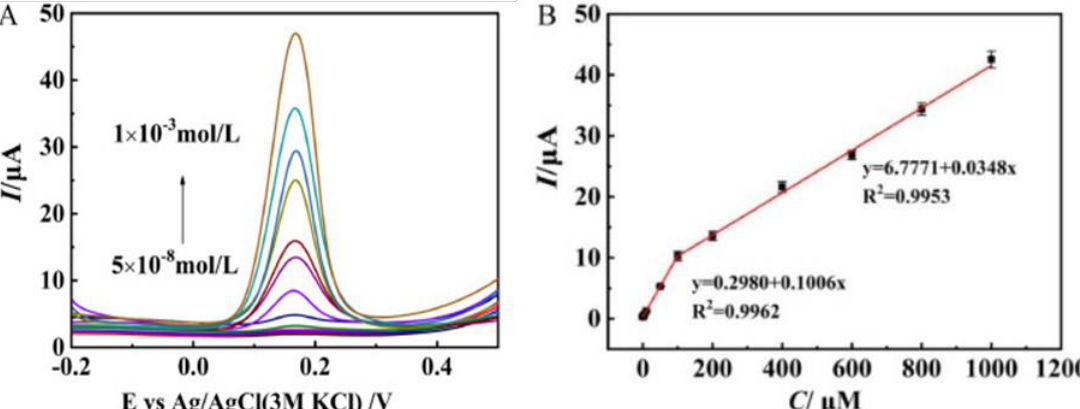
Figure 8. ( A ) DPV curves of S-MoSe 2 / NSG / Au / MIP / GCE to dopamine (DA) concentrations from 5 × 10 − 8 to 1 × 10 − 3 mol / L. ( B ) Peak current vs. DA concentration. Reprinted with permission from reference [83].